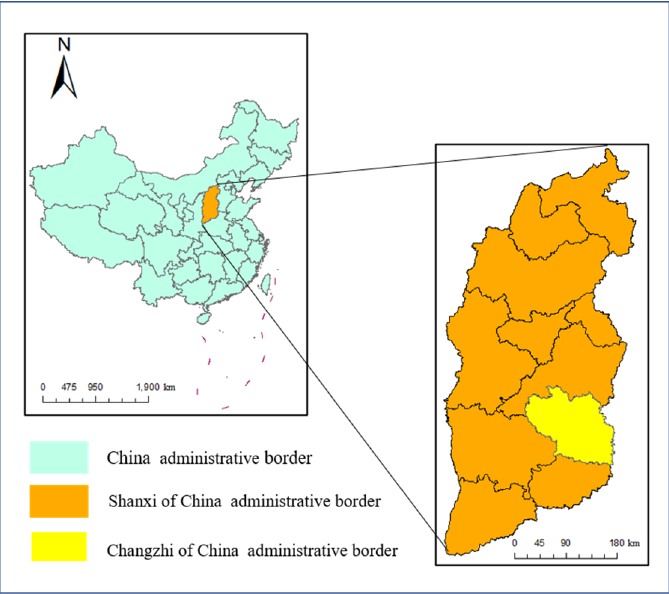
Figure 1. Geographical location of Changzhi, Shanxi Province, China.